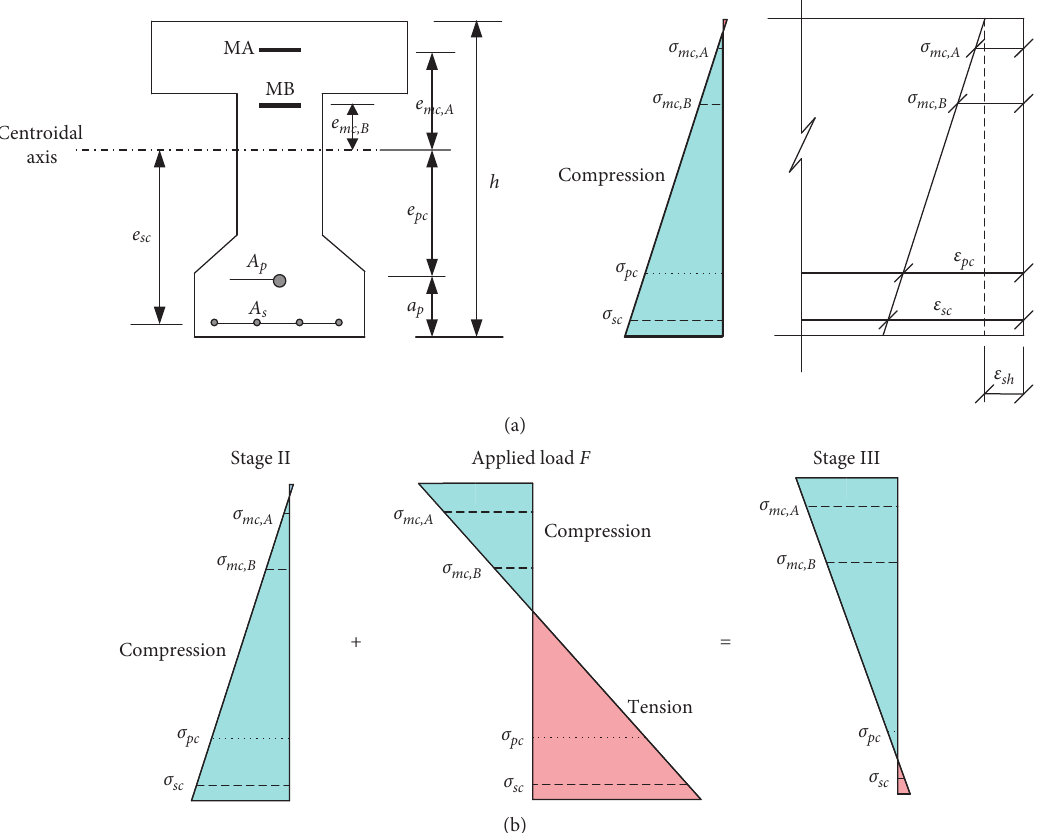
Figure 7: The stress and strain distributions of cross-section: (a) Stage II; (b) Stage